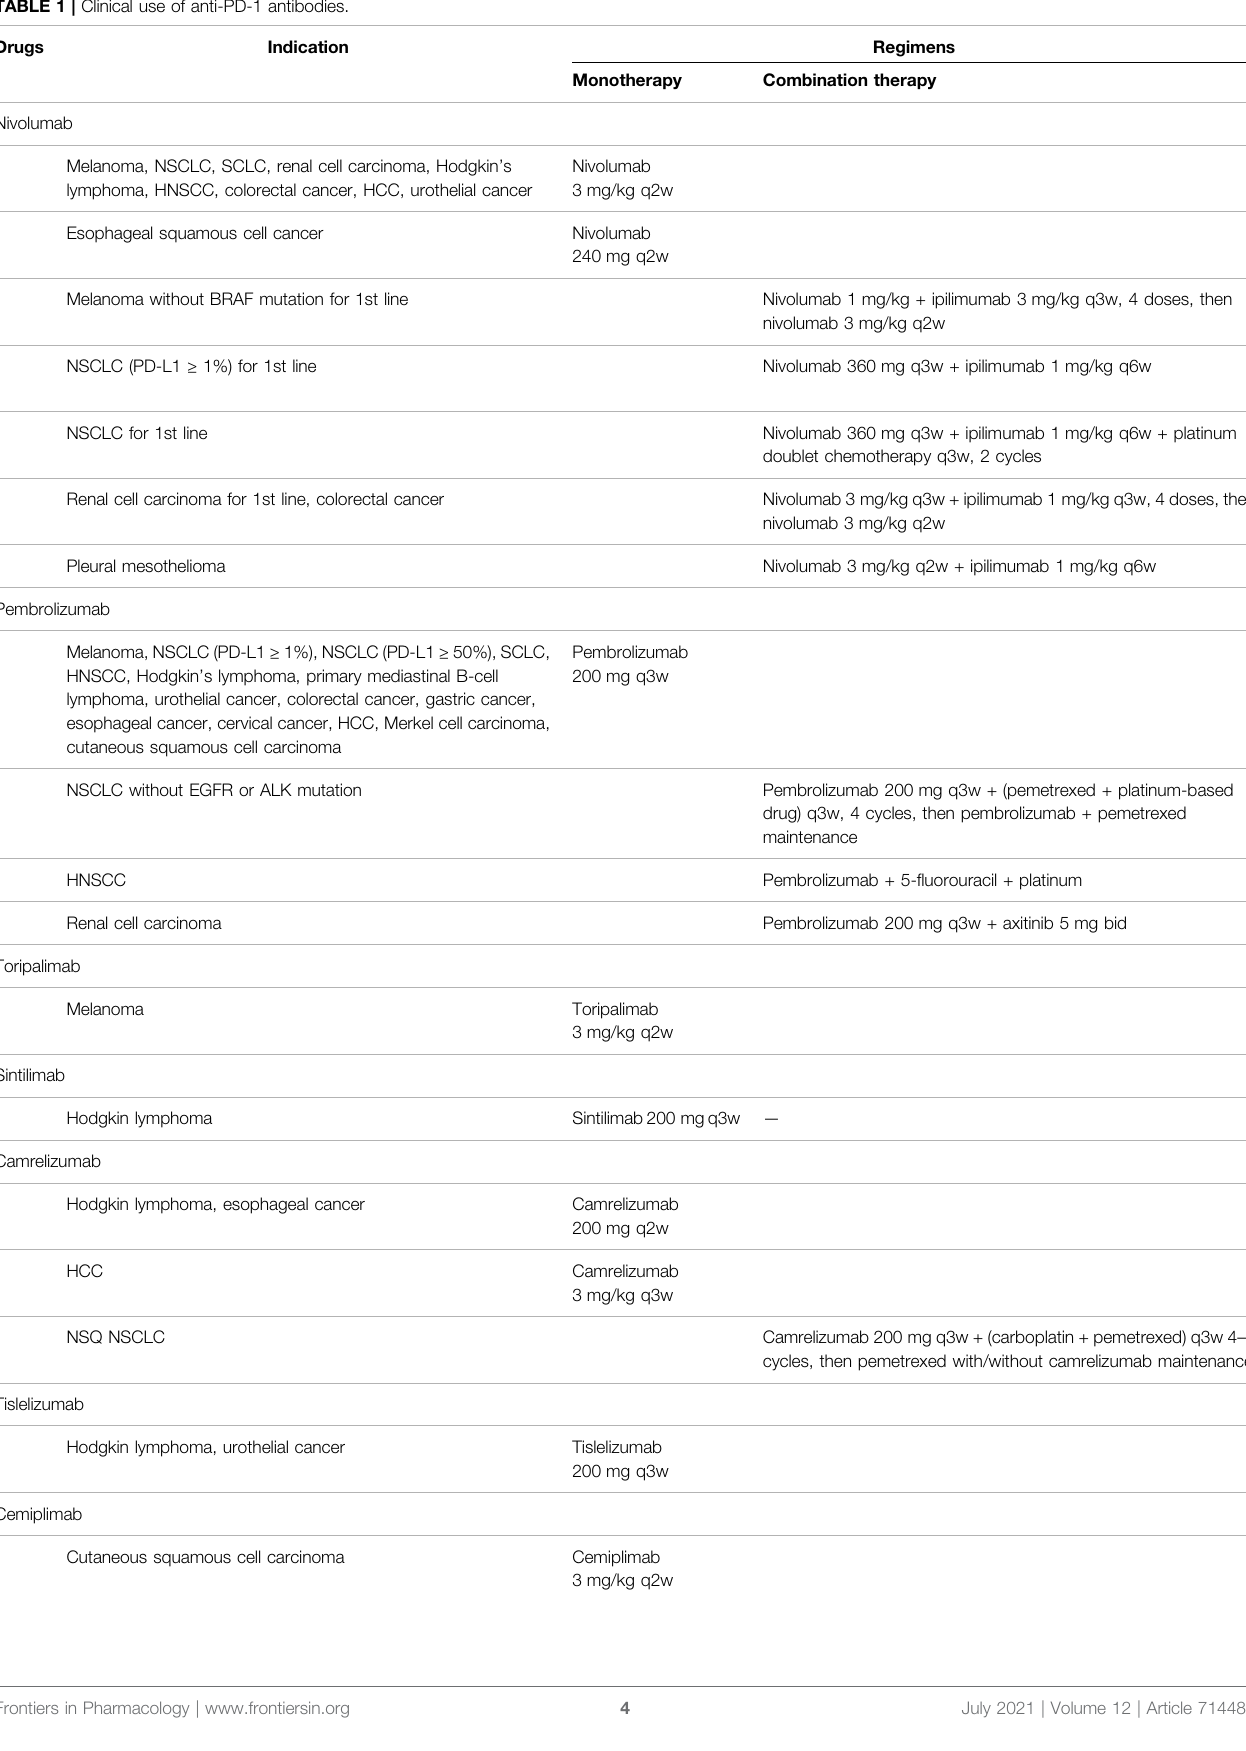
TABLE 1 | Clinical use of anti-PD-1